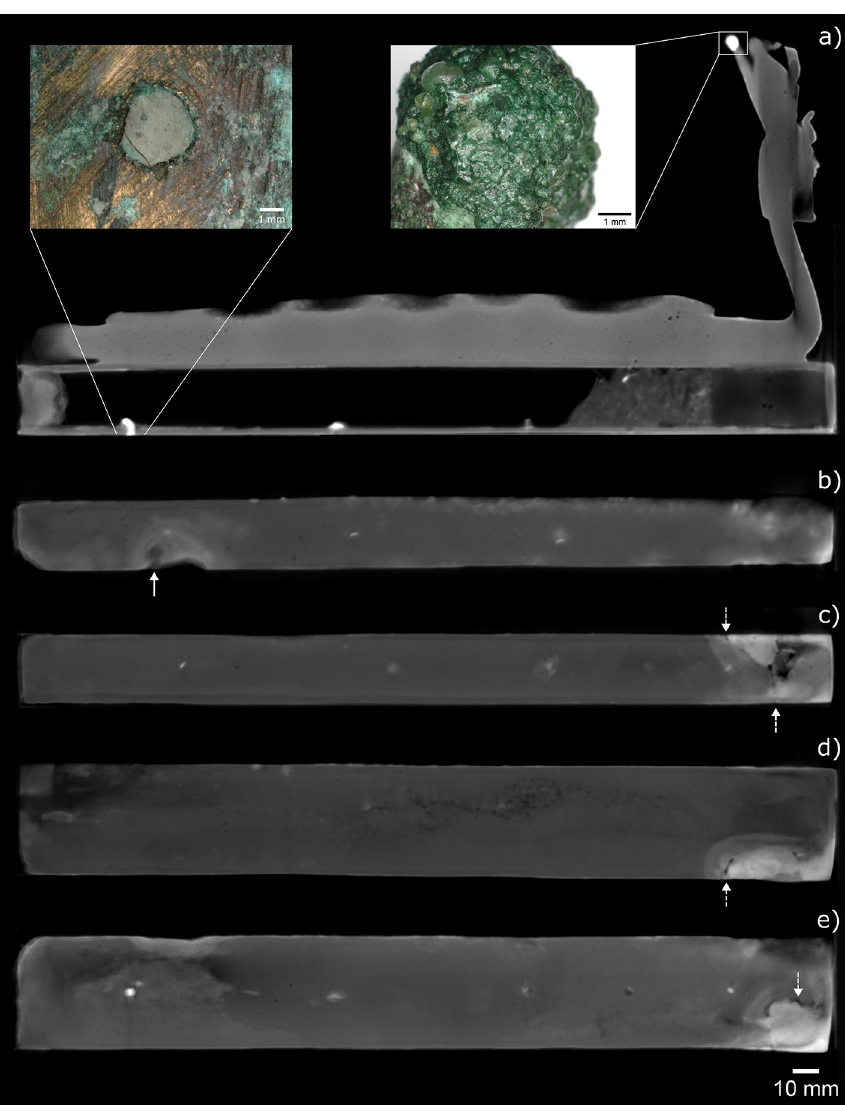
Figure 7. EA36151 neutron CT slices through the ( a ) centre, ( b ) left wall and ( c ) right wall of the box (side- view), ( d ) top and ( e ) base of the box (top-view). Inset microscope images in ( a ) show strongly attenuating material in the base of the box (20× magnification) and the crown of the hybrid figure (50× magnification). Solid arrow in ( b ) indicates an apparent ancient casting repair. Dashed arrows in ( c )–( e ) indicate cracks in the box walls, surrounded by strongly-attenuating resin from a past conservation treatment in the British